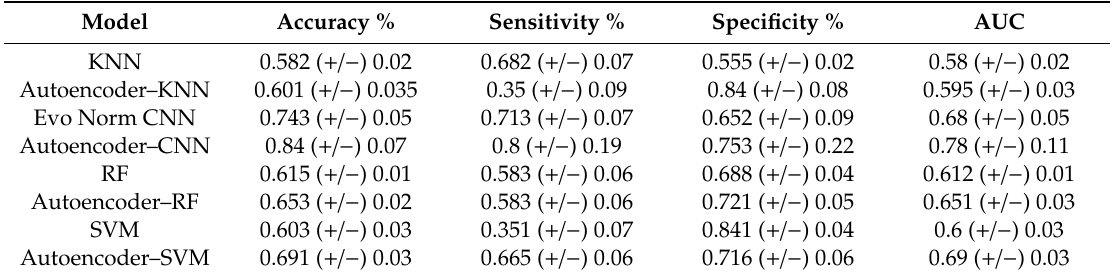
AUC: Area under the Curve.